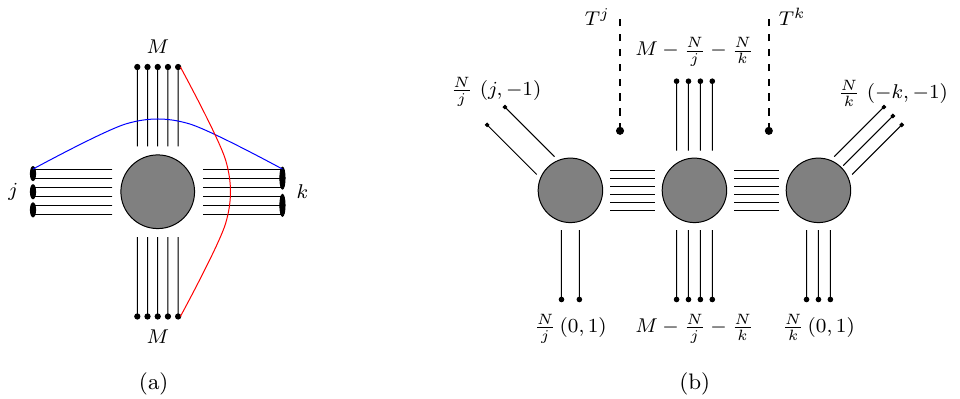
Figure 5 . The + N;M;k;j theory with N = 6, M = 5, j = 3 and k = 2 in 5(a), along with a D1 (red vertical curve) and an F1 string (blue horizontal curve) representing the stringy operators. Figure 5(b) shows a mass deformation for M (cid:21) N